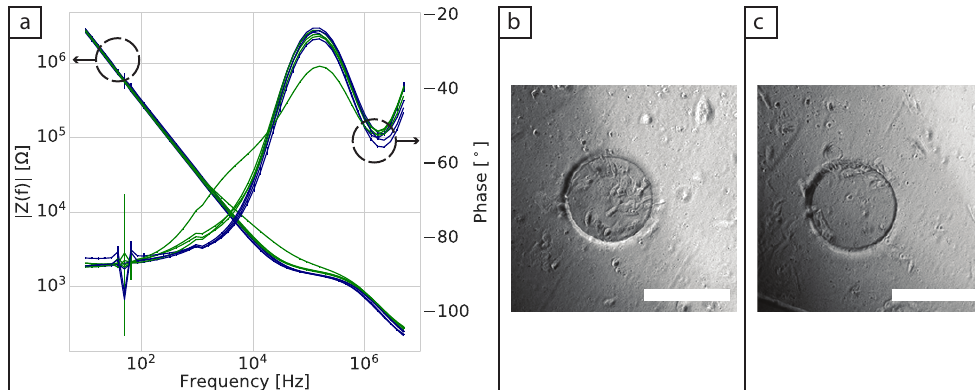
Figure 1. ( a ) Impedance spectra of BJ-5Ta cells 24 h after seeding in 2D. Blue lines are from control wells containing Dulbecco’s modified Eagle’s medium (DMEM) + fetal bovine serum (FBS) cell medium, while green lines are from wells containing cells and cell medium. ( b , c ) Bright field images of two of the wells seeded with cells after 24 h of culture. Scale bars = 250 µ